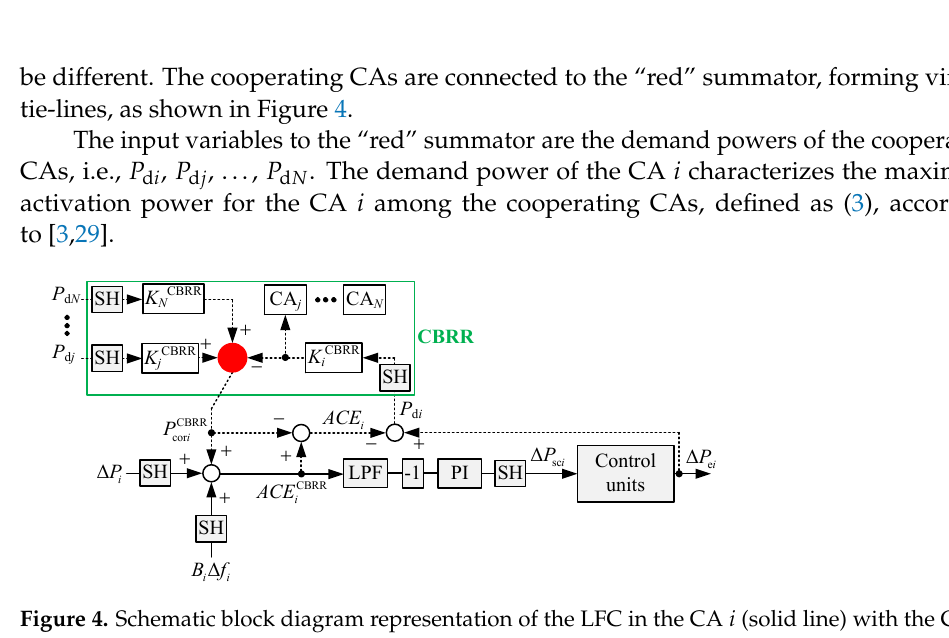
Figure 4. Schematic block diagram representation of the LFC in the CA i (solid line) with the CBRR (solid and dotted